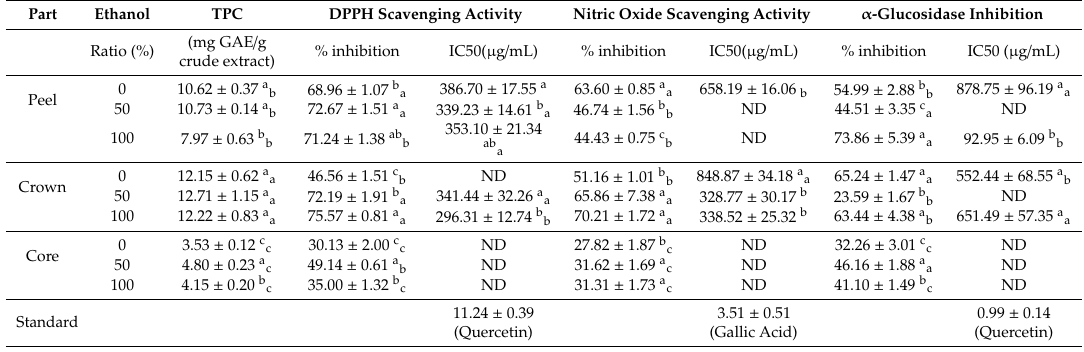
Table 1. The bioactivities of pineapple peel, crown and core extracted with 0, 50 and 100%